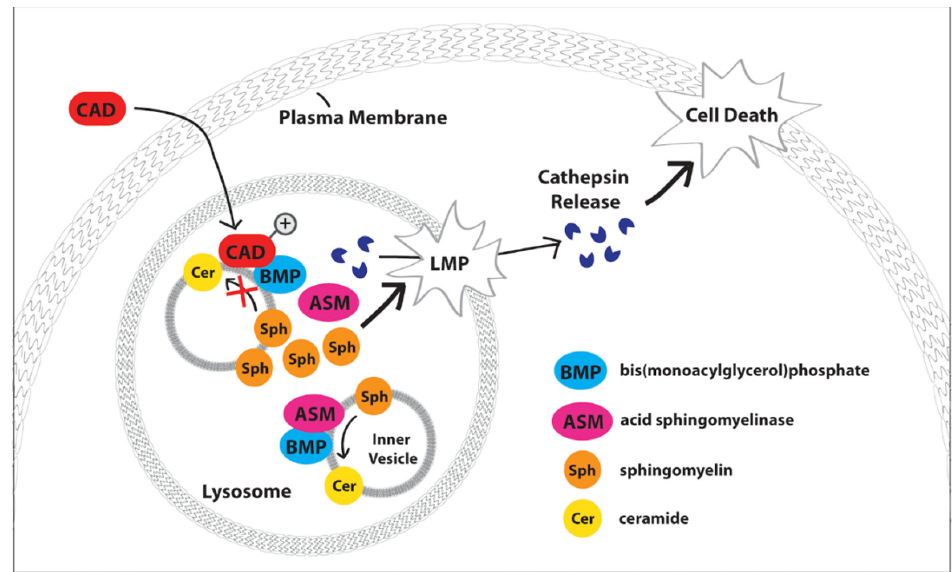
Figure 3. Schematic of BMP’s functional role within lysosomes. BMP serves as a docking site and critical cofactor for acid sphingomyelinase (ASM), which metabolizes sphingomyelin (Sph) to ceramide (Cer) at intraluminal vesicles (inner vesicles). Cationic amphiphilic drugs (CADs) rapidly